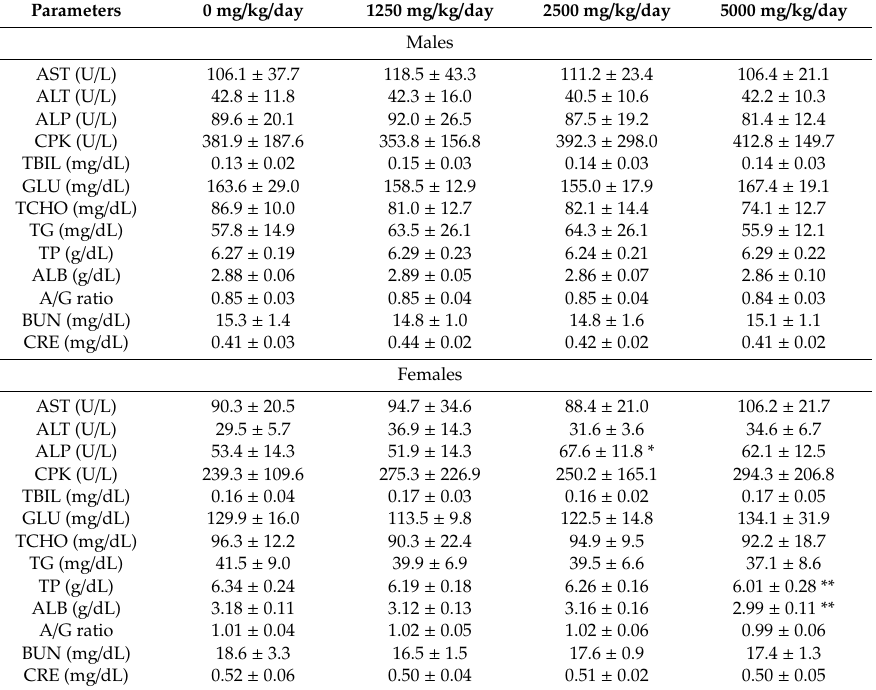
Table 4. Clinical Biochemistry data of SD rats orally administered frpfdZAL for 13 weeks. Parameters